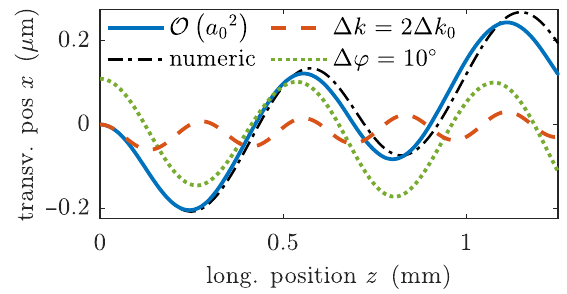
FIG. 5. Numerical and O ð a 0 − 2 Þ analytically approximated solutions for the reference trajectories x ð z Þ in an asynchronous DLA undulator with Δ k 0 =k 0 ¼ 0 . 36% detuning from synchro- nous operation, α ¼ 27 ° tilt angle, and E 0 ¼ 10 GV = m laser field strength. Both the laser detuning Δ k and the initial phase Δ φ influence the